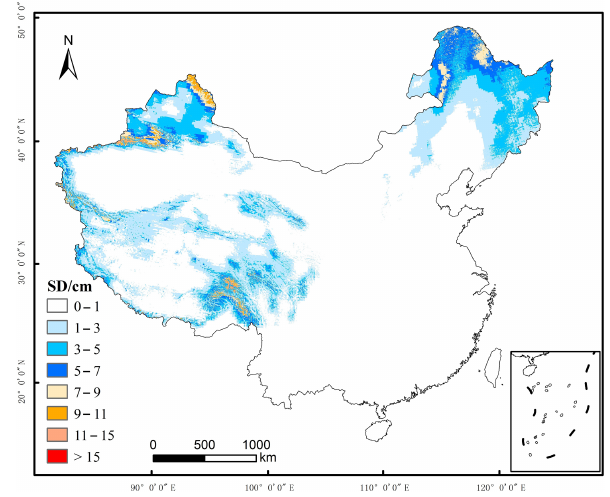
Figure 8. Spatial distribution of the average annual snow depth in China from December 2000 to November